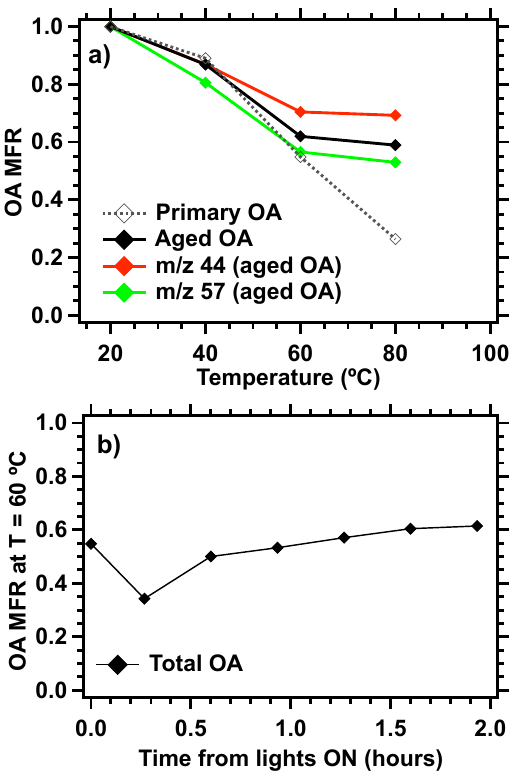
Fig. 9. Thermodenuder data: (a) average thermograms for primary OA, aged OA, and AMS fragments m/z 44 and 57 for the aged aerosol (b) evolution of total OA volatility at T = 60 ◦ C during the photo-oxidation phase of the experiment. Data are from a 4% en- gine load experiment. Lines are included to help guide the eye.